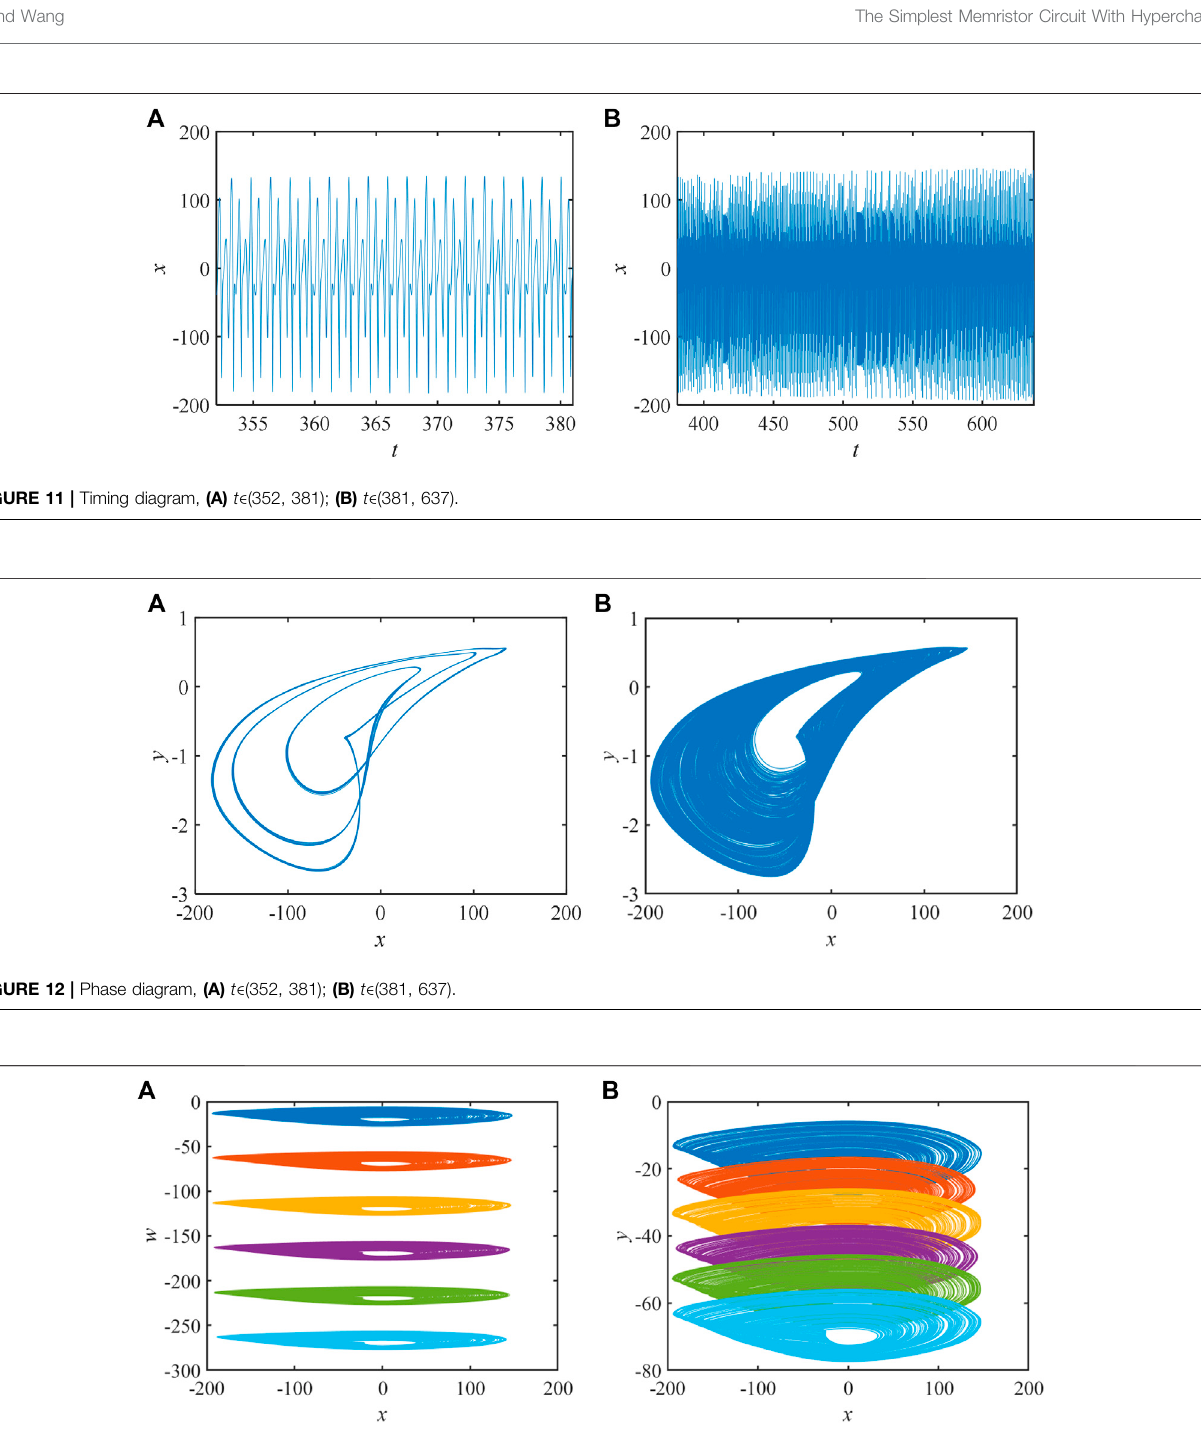
FIGURE 13 | Coexisting attractors with different z 0 and w 0